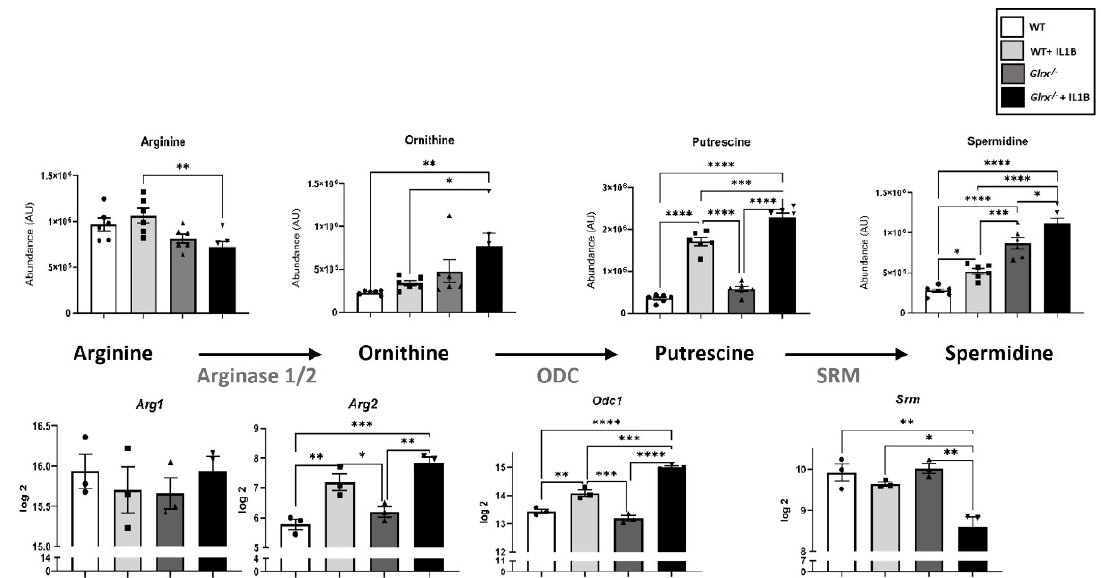
Figure 1. GLRX-dependent modulation of metabolic pathways that use arginine and give rise to spermidine in airway basal cells stimulated with IL1B. WT or Glrx − / − airway basal cells were stimulated with 10 ng/mL of IL1B for 24 h prior to the assessment of gene expression or metabolite analysis in cell lysates. We refer the reader to Aboushousha et al. [17] for technical details about this study. * p < 0.05, ** p < 0.01, *** p < 0.001, **** p < 0.0001, ANOVA .